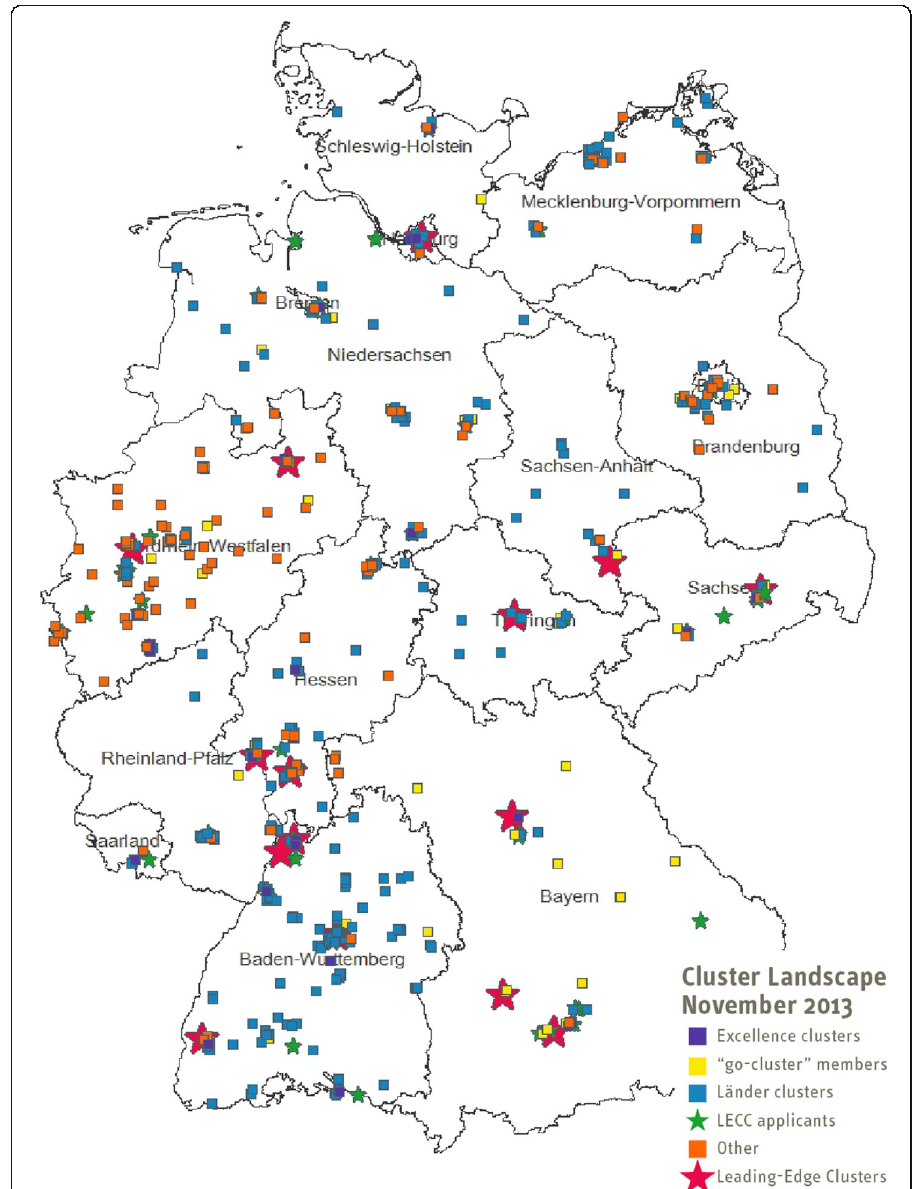
Fig. 2 Clusters and networks at the federal and Länder level in Germany. Source: Accompanying evaluation of the LECC; based on an own inquiry (date: November 2013). – Comments: Locations are given for the contact address of the cluster organisations. If a cluster is represented in several categories (e.g. a Leading- Edge Cluster and member of go-cluster), then it will be shown once in the graphic. The map was created using RegioGraph